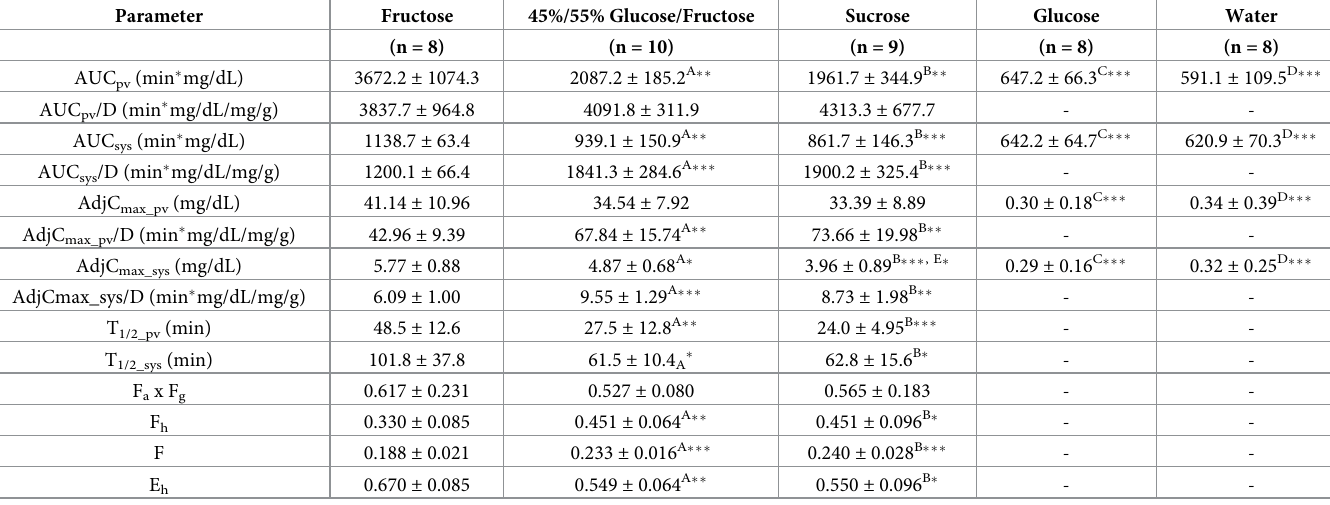
AdjC max = maximum observed concentration—concentration at time = 0. AUC = area under the curve. AUC/D = area under the curve normalized by fructose dose. E h = hepatic extraction ratio. F = systemic bioavailability. F a X F g = intestinal availability. F h = hepatic availability. PV: portal vein. SYS: femoral vein. A: fructose vs